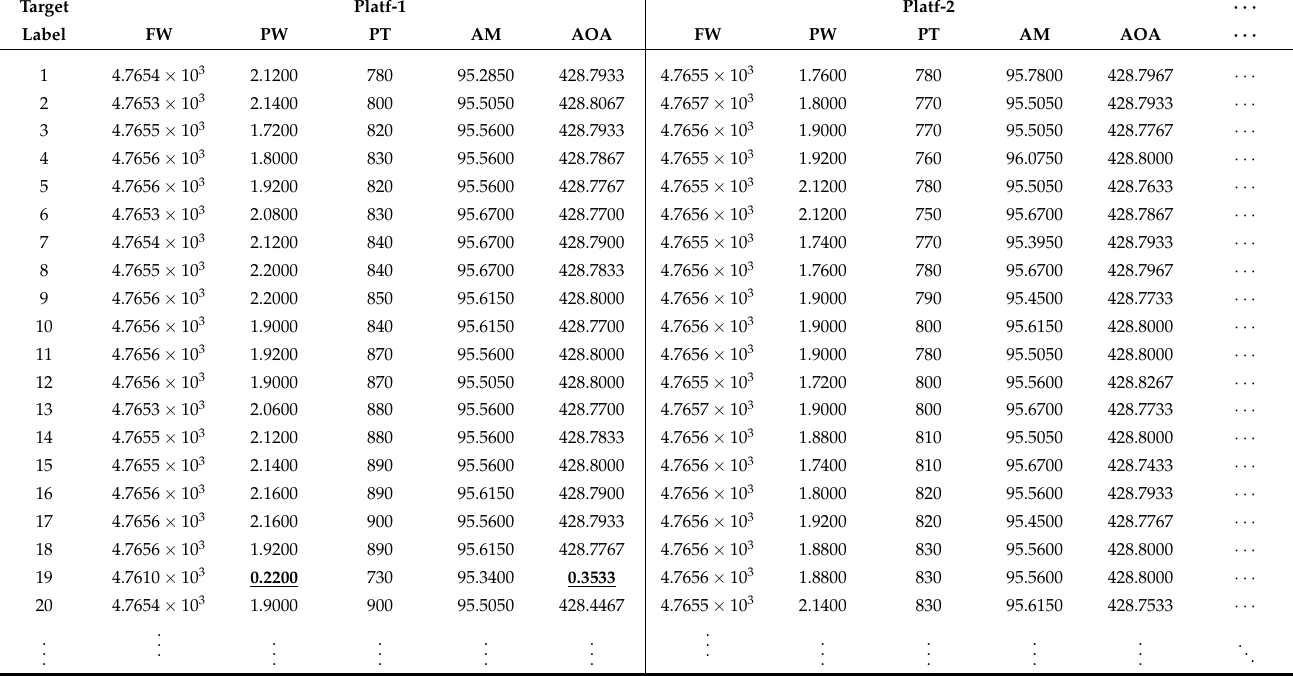
Table 7. Real data X